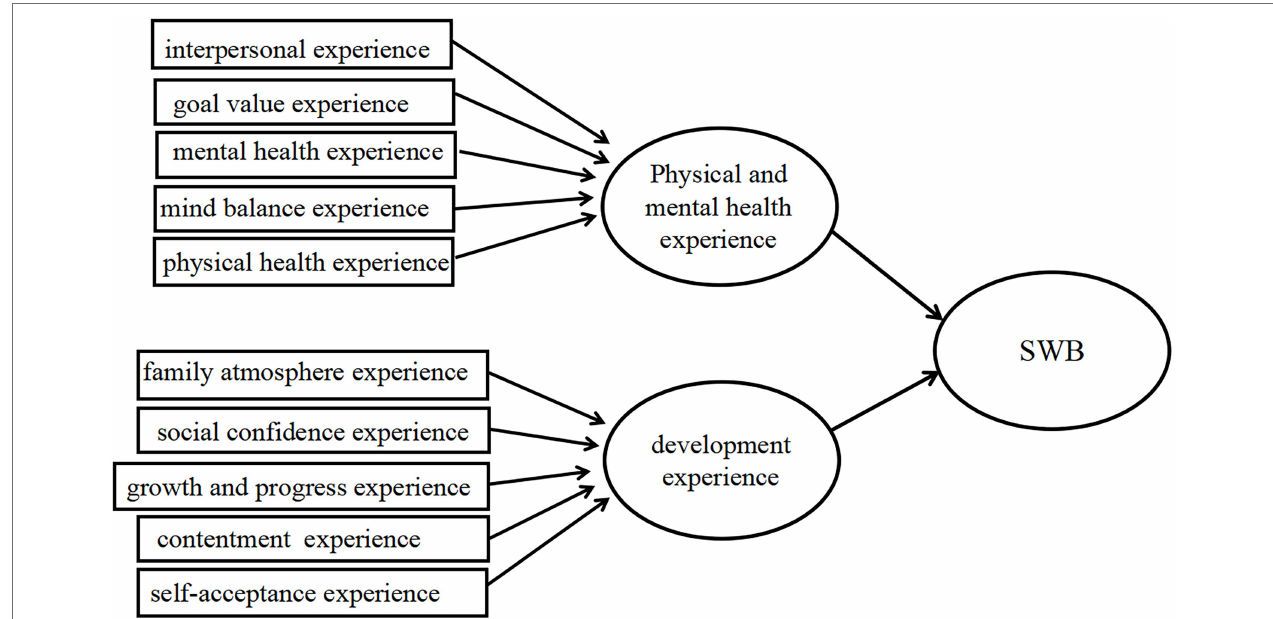
FIGURE 1 | The model of modified Subjective Well-Being Scale for Chinese Citizens